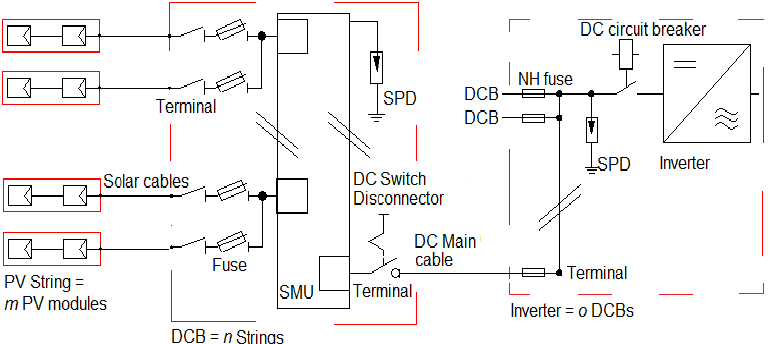
Figure 3. Single-line diagram of the DC side of the PV plant using a CI. For the sake of simplicity, a line presents a cable system, for example two conductors for DC (+ and −). Modules are connected in series while strings are in parallel.